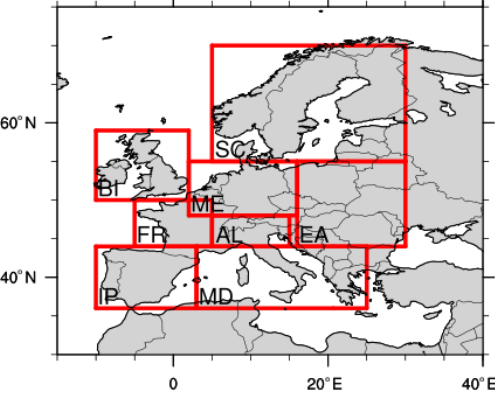
Figure 1. The regions for which precipitation data are anal- ysed: Scandinavia (SC), British Isles (BI), mid-Europe (ME), France (FR), the Alps (AL), eastern Europe (EA), Iberian Penin- sula (IP), and the Mediterranean